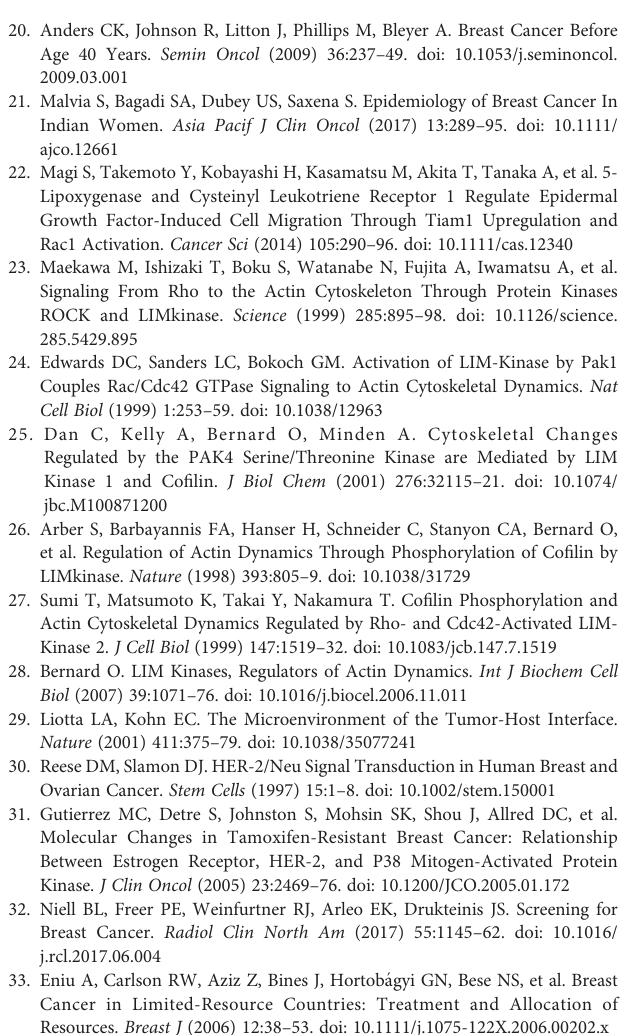
Supplementary Figure 1 | Immobilization of LOX5, Rac1, Rac1b, p38 a , hosphor-p38 a (Y-182), LIMK1, hosphor-LIMK1 (T-508), co fi lin1, and phospho- co fi lin1 (S-3) antibodies on CM5 sensor chip.